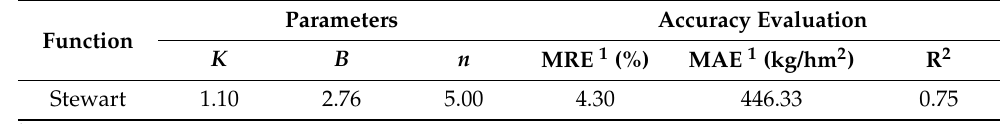
Table 1. Results of fitted water production function and accuracy evaluation [54]. Parameters Function